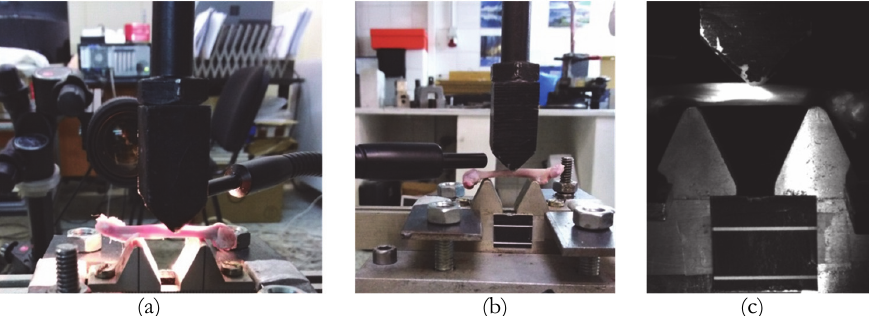
Figure 1: (a,b) Both sides of the experimental set-up used; (c) A typical image taken by the video-extensometer during the